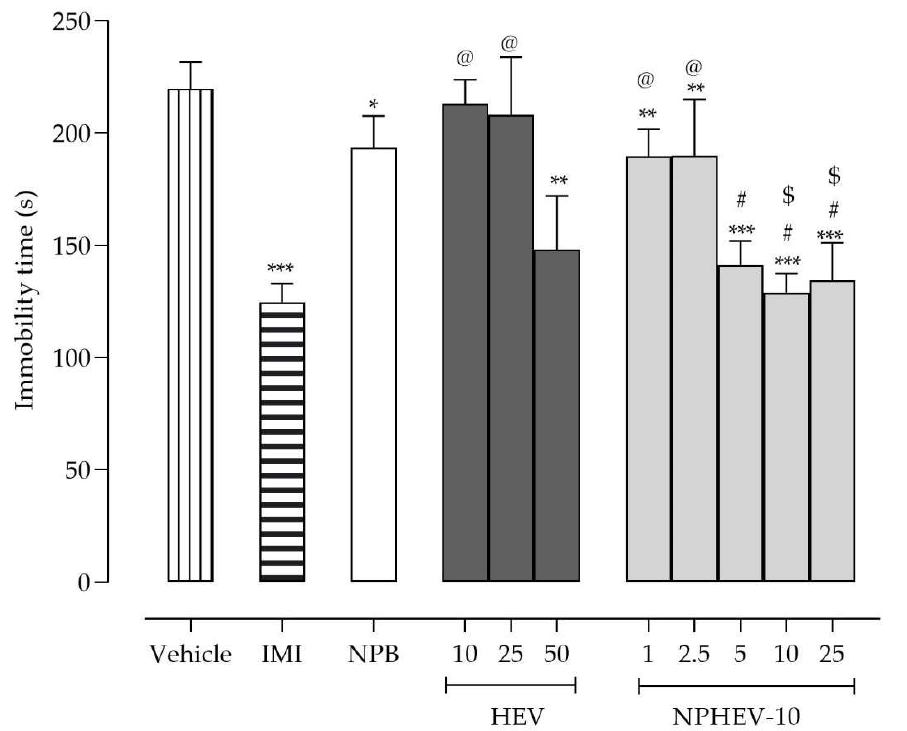
Figure 4. Dose–response curves of HEV (10, 25, and 50 mg/kg), NPHEV-10 (1, 2.5, 5, 10, and 25 mg/kg), NPB, and Imipramine (IMI, 20 mg/kg) after intragastric acute treatment in FTS. Values are expressed as mean ± SEM. Asterisks denote the significant difference in comparison to the vehicle (* p < 0.05; ** p < 0.01; *** p < 0.001), sharps indicate the difference in comparison to NPB ( # p < 0.05), arroba denotes a significant statistical difference with imipramine group ( @ p < 0.05), and cipher denotes the significant difference between the same doses of HEV and NPHEV-10 ( $ p < 0.05). All data were tested using ordinary one-way ANOVA, followed by Newman-Keuls’ test .